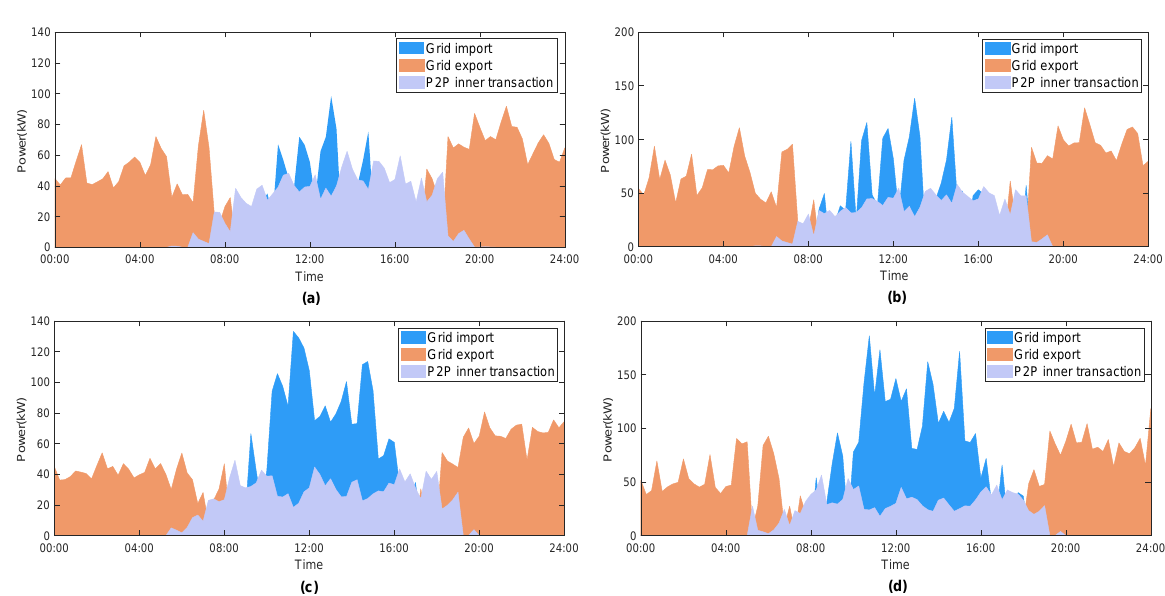
Figure 5. Type day profile of the whole community: ( a ) weekday-SBEMS, ( b ) weekday-reference, ( c ) weekend-SBEMS, and ( d )